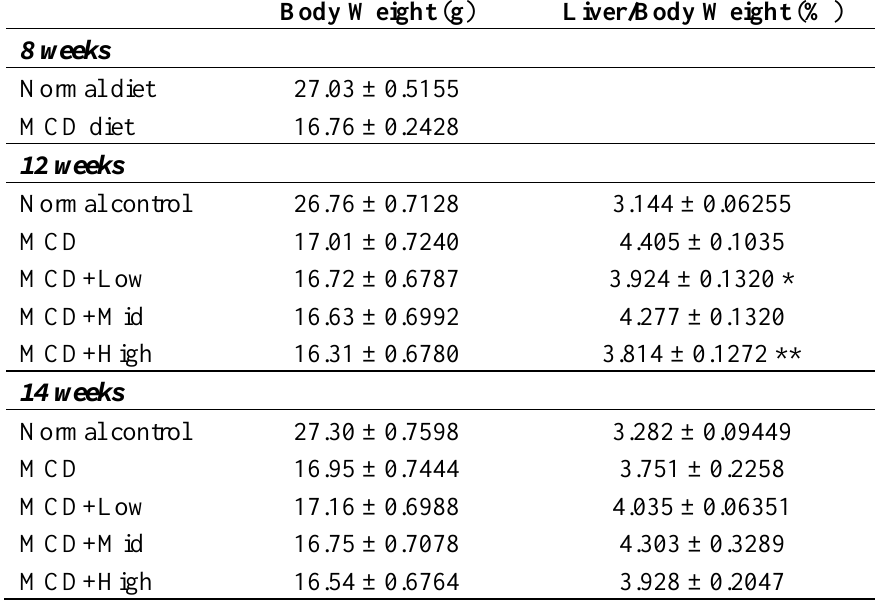
Table 1. Body (g) and liver/body weight (%) of animals in each group before treatment (8 weeks) and after treatment (4 and 6 weeks) during the experimental